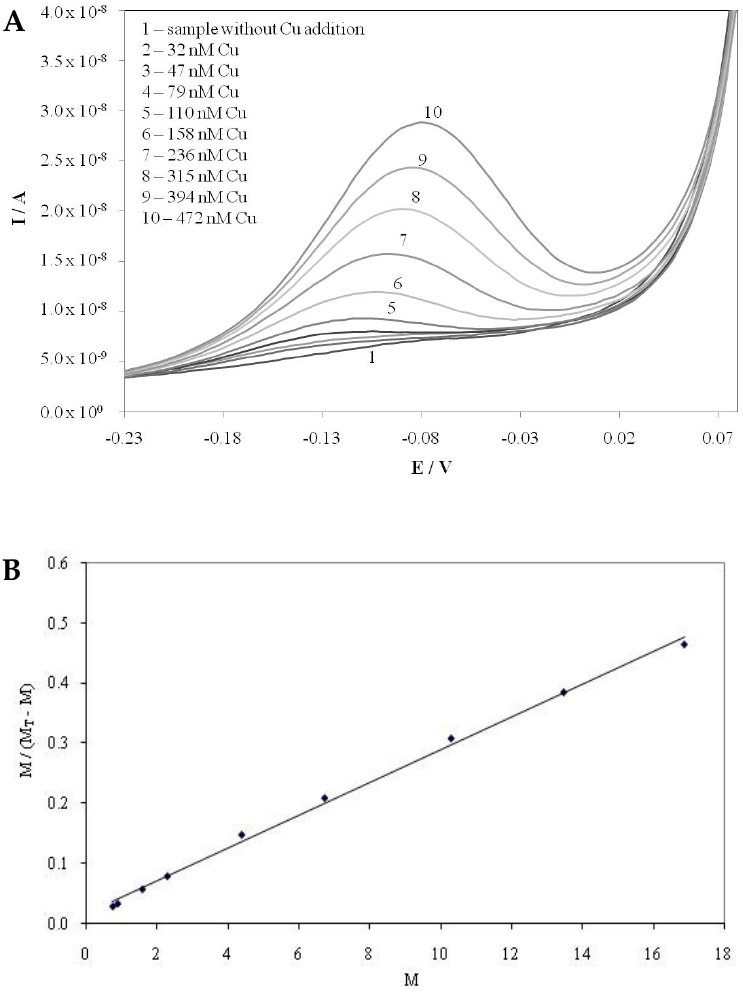
Figure 4. DPASV voltammograms of Cu ion titrations ( A ) and Ruzic–van den Berg plot ( B ) for the balsamic vinegar sample BR5.